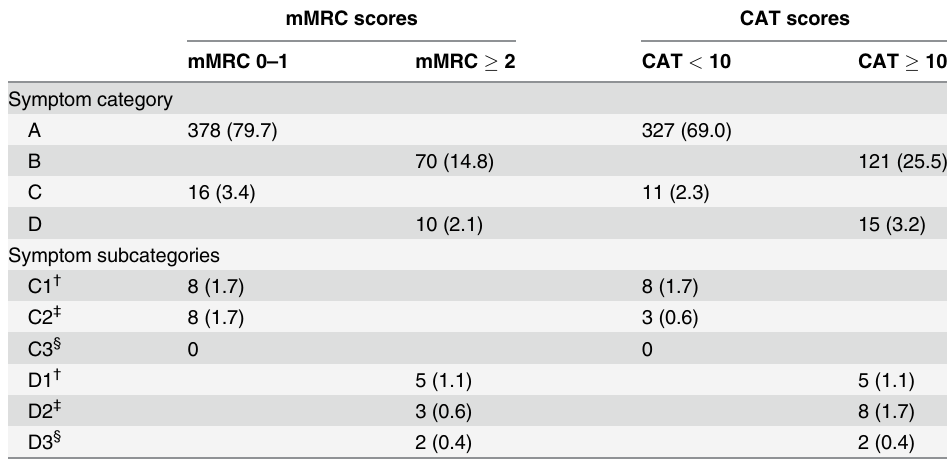
* N = 474 † Meets FEV1 criteria ( < 50% FEV1 predicted).